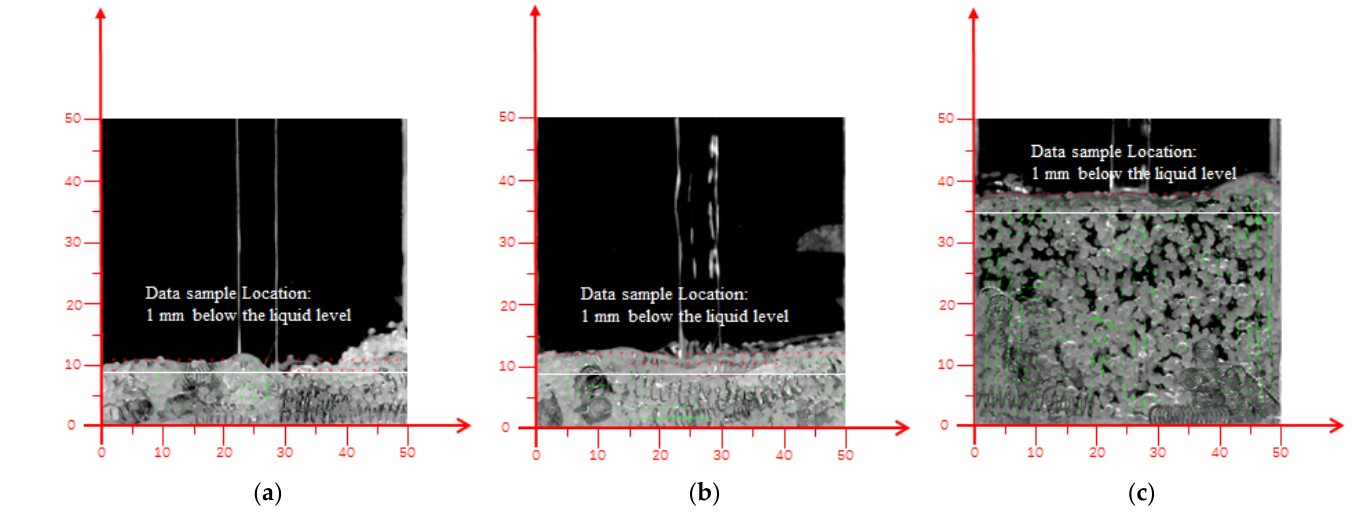
Figure 4. Three physical forms of the hydraulic jump (casting speed of 2.40 m/min, mode 4). ( a ) CHJ. ( b ) HJT. ( c ) SLL. Table 1. Geometric parameters of the mold and experimental condition.